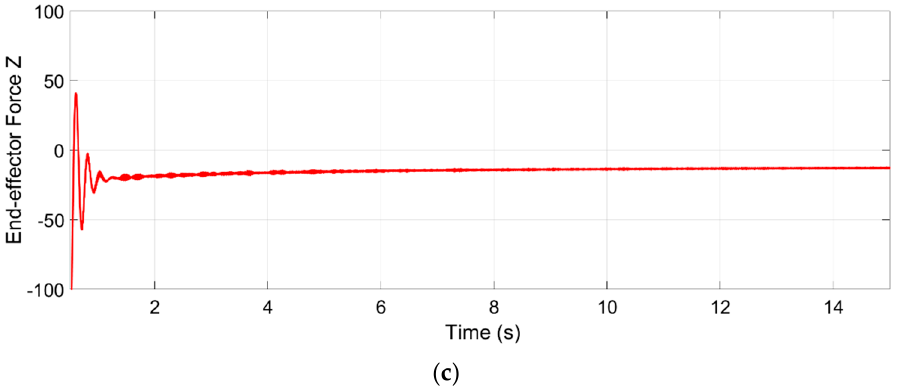
Figure 21. Forces acting on the end-effector. ( a ) Force in the x -axis from 215 to 199 N. ( b ) Force in the y -axis from 5.75 to − 12 N. ( c ) Force in the Z axis from − 22.8 to − 13.3 N.